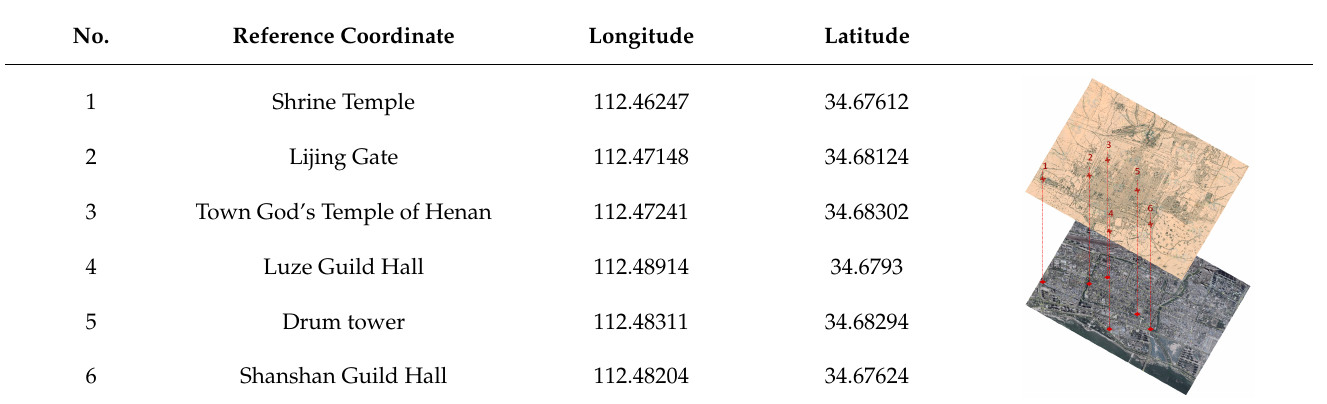
Table 2. Six precise reference coordinates.